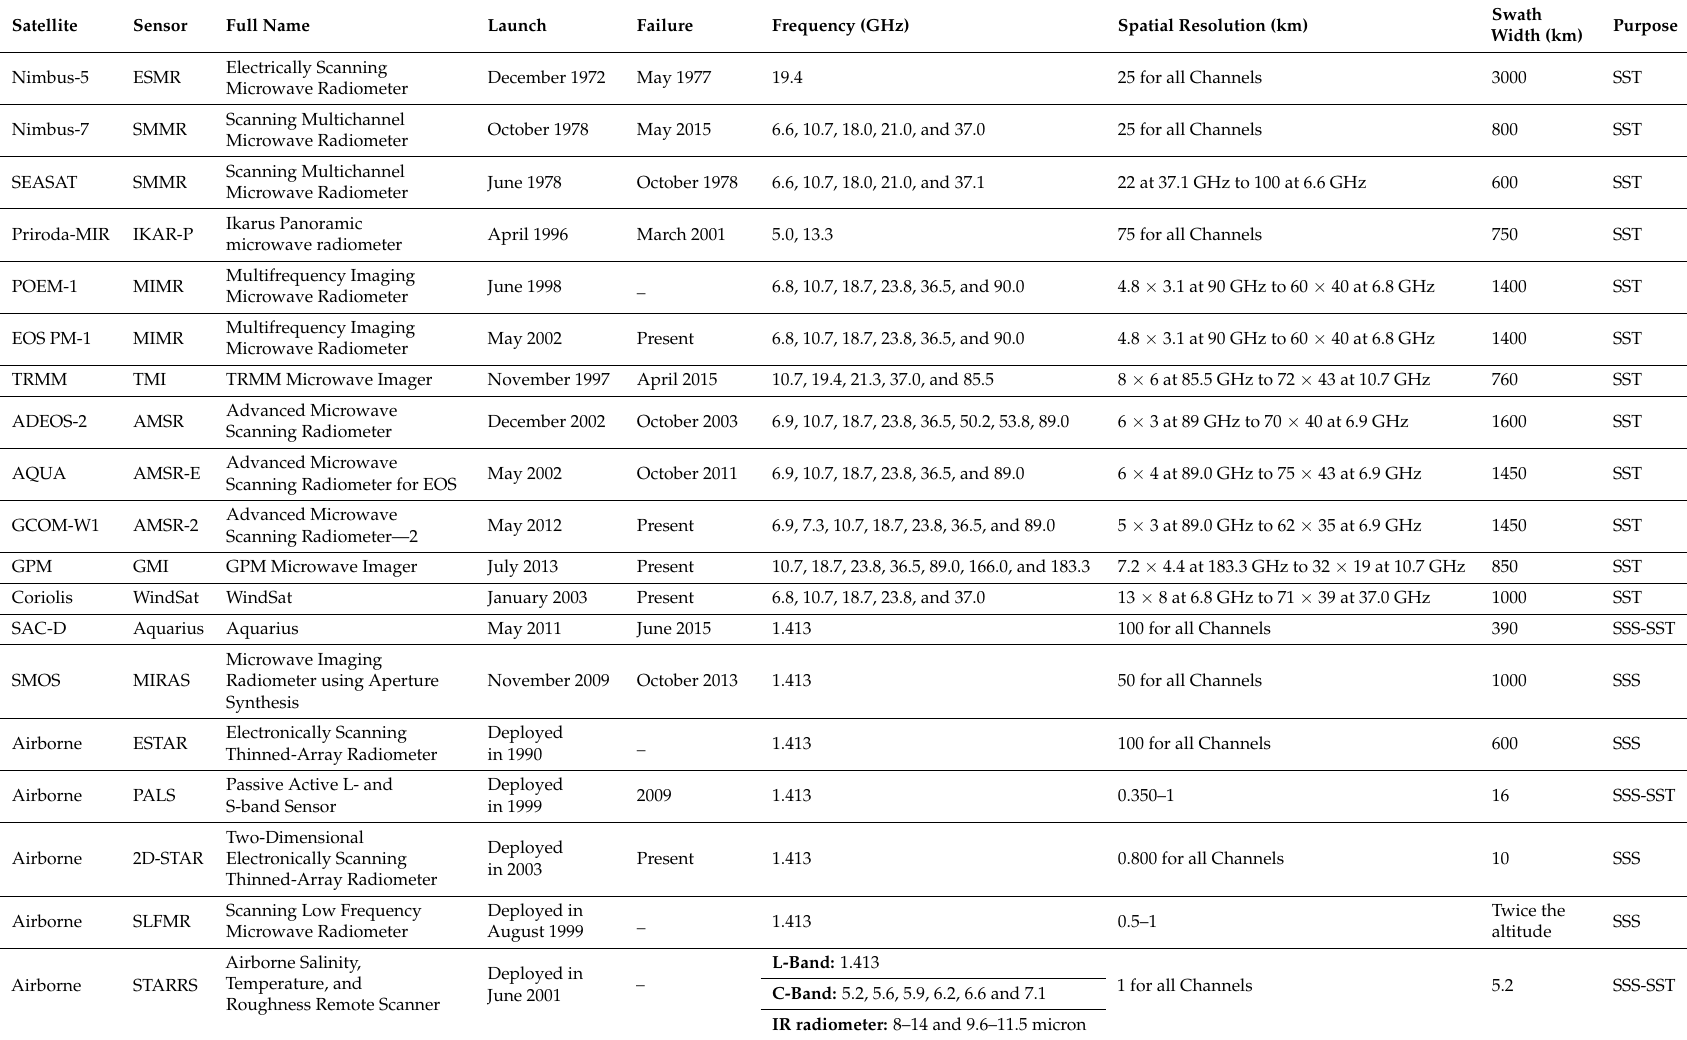
Table 3. Characteristics of the more commonly used microwave radiometers in oceanography and water quality